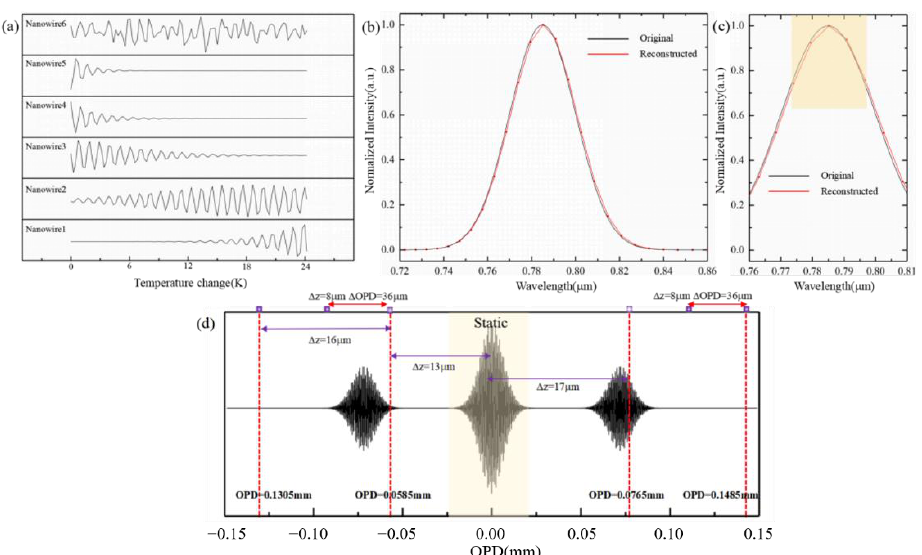
Figure 3. ( a ) Sampling data recorded by 6 nanowires at each tunable temperature, ( b ) the recon- structed spectrum (black) obtained by FT and the original incident Gauss spectrum (red), ( c ) a partial enlarged view, ( d ) the position of the gold nanowires corresponding to the dynamic inter- ferogram.